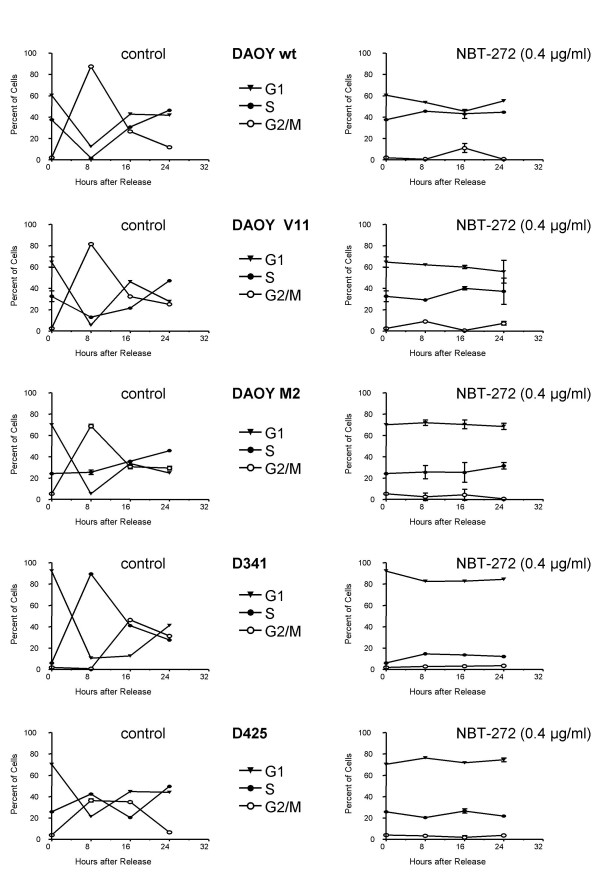
Block of the cell cycle progression in synchronized MB treated with NBT-272. MB cells were synchronized by hydroxyurea treatment as described in Methods and treated with NBT-272 or the same volume of medium as control. FACS analysis of NBT-272 and control cells carried out 0, 8, 16, and 24 h posttreatment. Results are presented as the mean percentages of cells in G1, S, and G2/M ± SD (n = 2; ± SD).